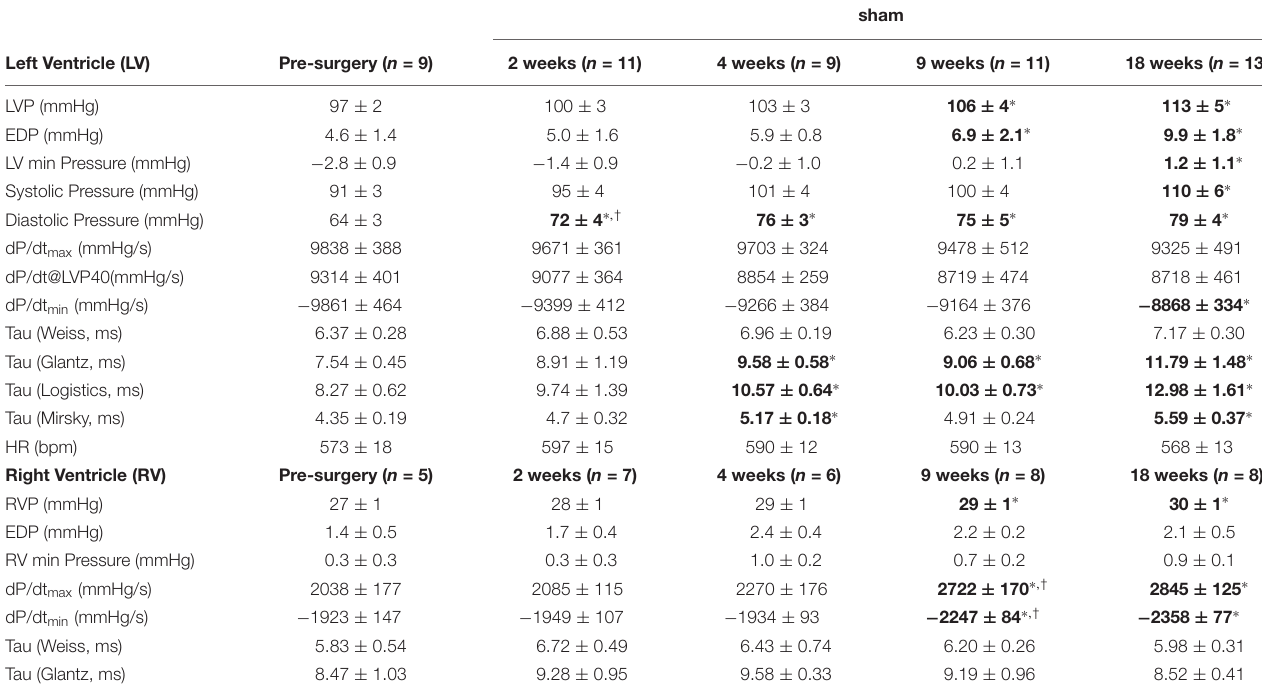
TABLE 2 | Invasive hemodynamics from the left and right ventricles in